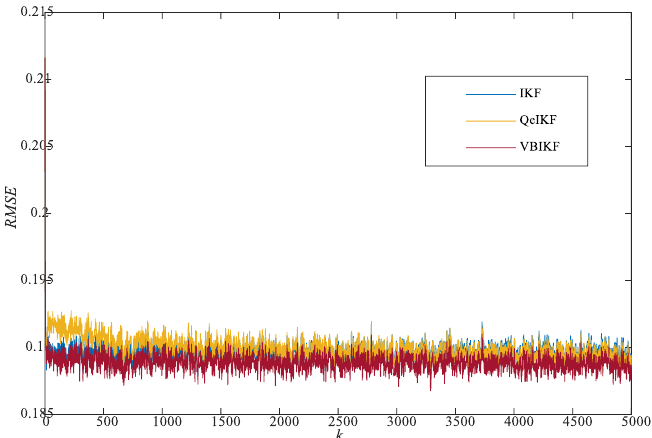
Figure 3. The RMSE k result of the IKF, the QeIKF, and the VBIKF for the scaled ˆ Σ w with α = 2. Figure 3. The